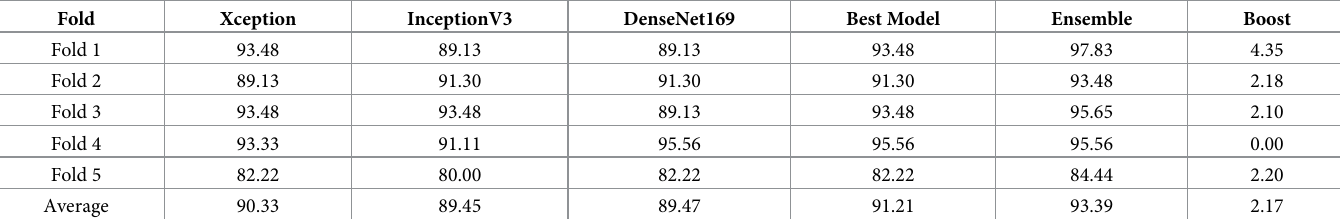
Table 2. Performance comparison with respect to accuracy for the base learners and the proposed ensemble method on the Monkeypox skin lesion dataset using 5-fold cross-validation methodology. All values are reported in %. Fold